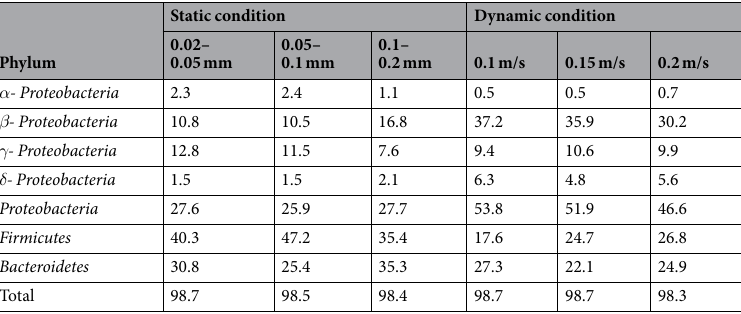
Table 2. The relative abundances of the dominant phyla, including the Proteobacteria classes